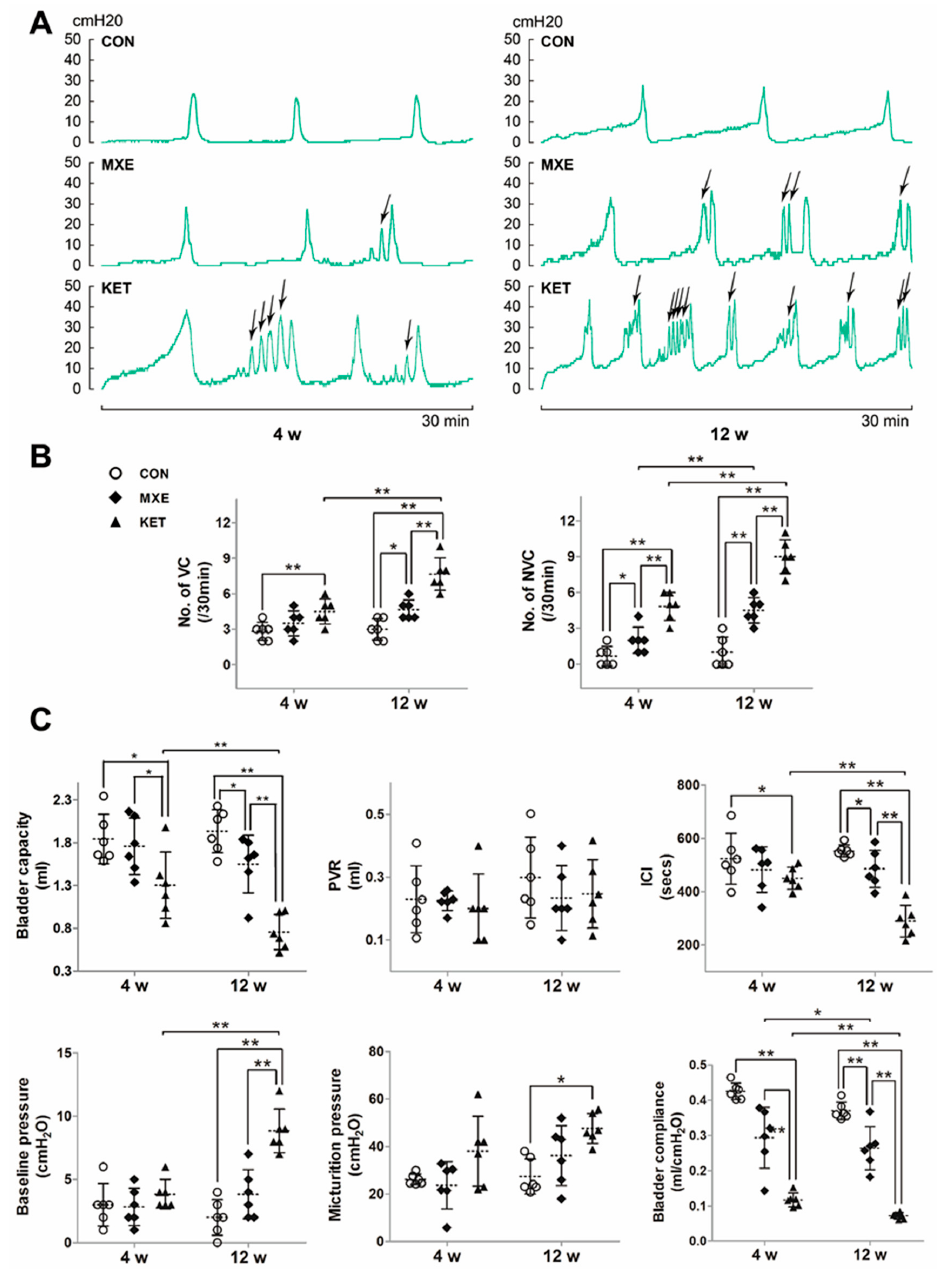
Figure 3. Abnormal voiding patterns of rats due to drug treatment. ( A ) Typical cystometric recordings in the three groups of rats after four or 12 weeks of treatment (30 min, intravesical pressure unit: cm H 2 O, n = 6 in each group). The frequency of non-voiding contractions (NVCs) was marked with arrows; ( B ) the frequency of non-voiding contractions (NVCs) was increased in the KET and MXE groups; ( C ) the urodynamic parameters evaluated included voiding contractions (VCs) and non-voiding contractions (NVCs); and bladder capacity, post-void residual (PVR), inter-contraction interval (ICI), baseline pressure, micturition pressure and bladder compliance. Data were analyzed with two-way ANOVA. * p < 0.05, ** p < 0.01.